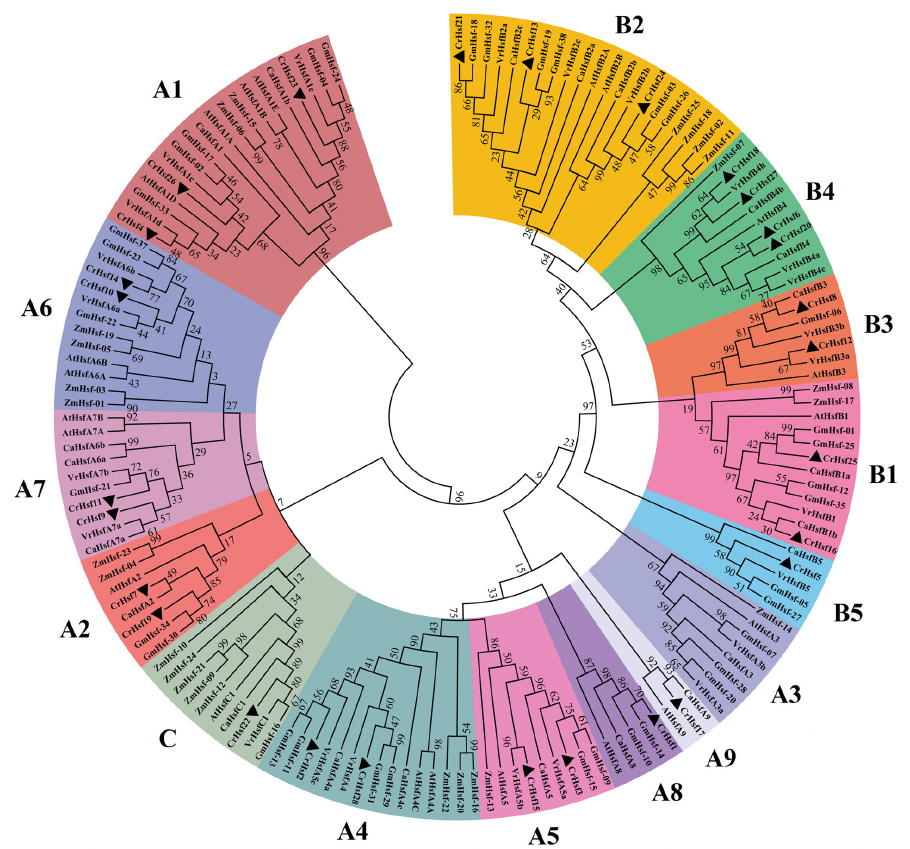
Figure 1. Phylogenetic relationships of the 28 CrHsfs from Canavalia rosea , the 38 GmHsfs from soybean ( Glycine max ), the 22 CaHsfs from chickpea ( Cicer arietinum ), the 24 VrHsf from mung bean ( Vigna radiata ), the 25 ZmHsfs from maize ( Zea mays ), and the 21 AtHsfs from Arabidopsis ( Arabidopsis thaliana ). The phylogenetic tree is constructed using MEGA 6.0 software with the Hsf protein sequences, by ClustalW alignment, the neighbor-joining (NJ) method, the bootstrap method, and 1000 repetitions. All subclasses (A1–A9, B1–B5, and C) of Hsf proteins are well separated in different clades and represented by different color backgrounds.